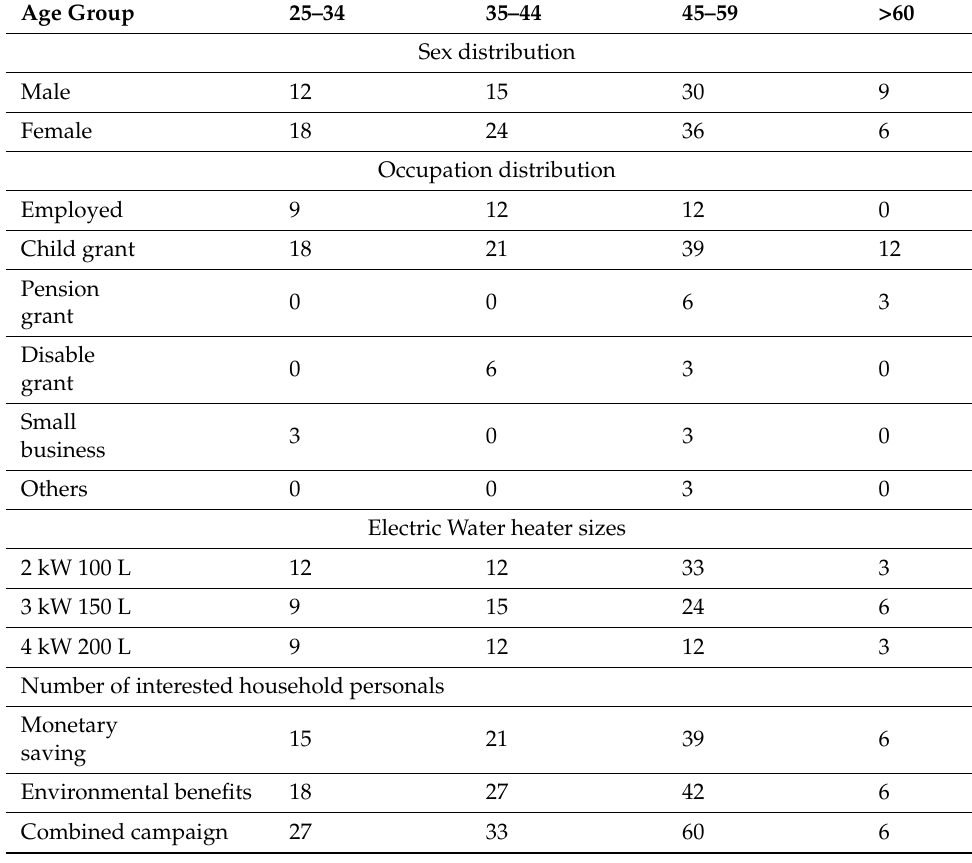
Table 5. Sample population and their responses to the utilization of an SWH after each phase of the